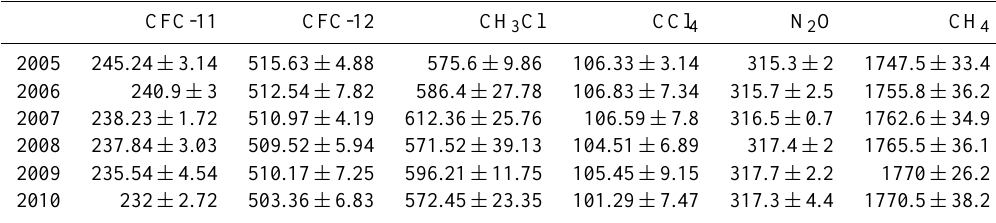
Table A2. The mean volume mixing ratio at the tropopause ( σ 0 )